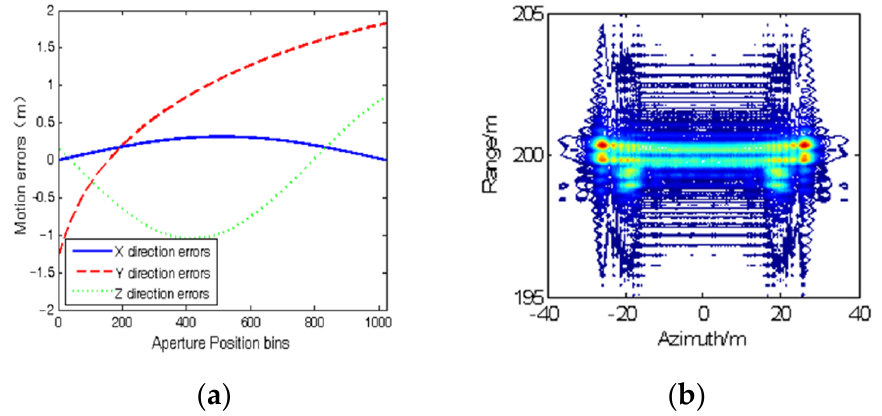
Figure 4. ( a ) Measured motion errors in different directions; ( b ) imaging results of points 1 and 2 using CSA without MOCO.